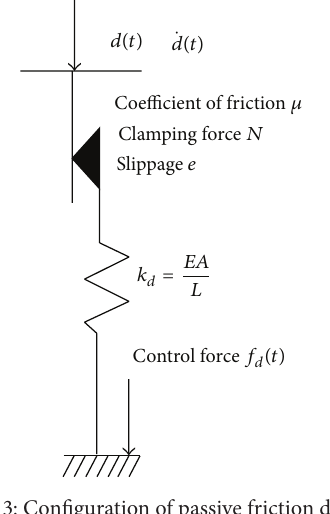
Figure 3: Configuration of passive friction damper.